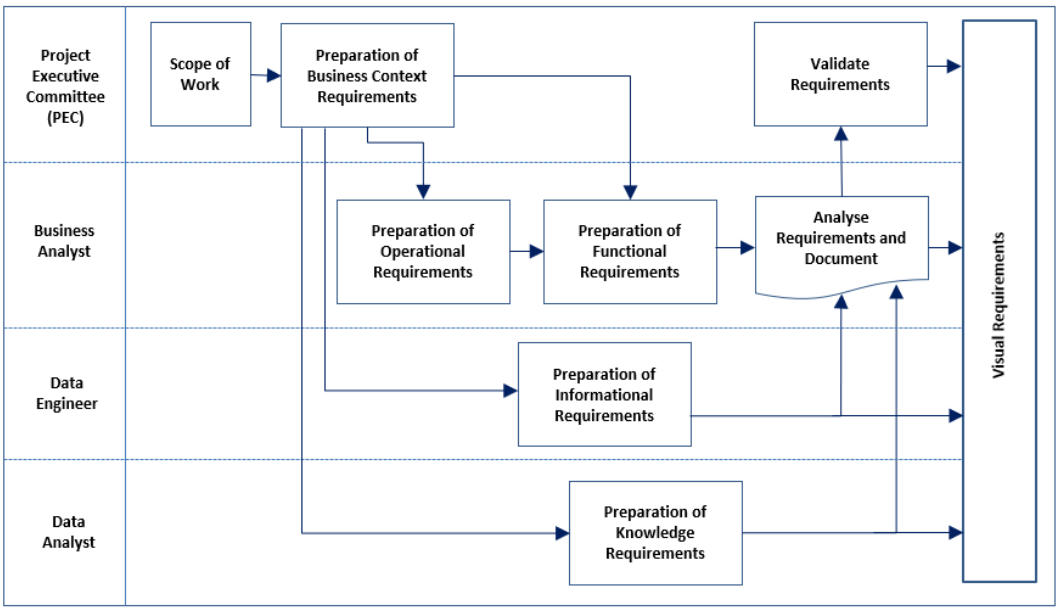
Fig. 6 Requirement development process for Operational